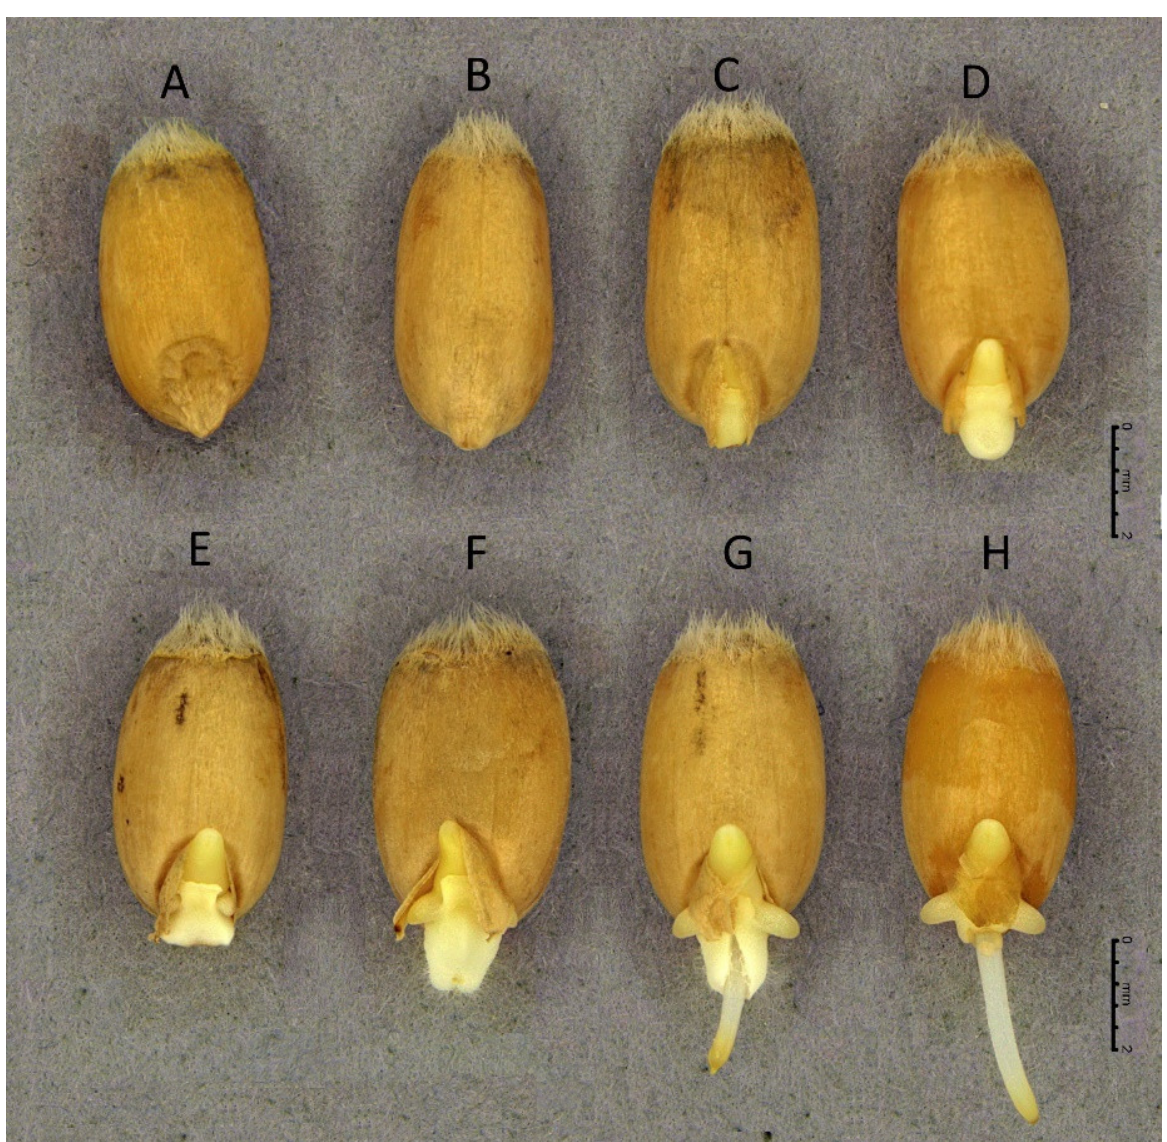
Figure 3. Morphological characteristics of big seeds of winter wheat ( Triticum aestivum ) during the first 24 h of germination, after seeding (AS) on moistened filter paper, illustrating the visible emergence events: ( A ) Dry seed at 0 h AS; ( B ) Imbibed seed with an expanded embryo at 4 h AS; ( C – E ) Seeds with emerged coleorhiza between 8–12 h AS; ( F ) Seed with emerged coleorhiza nearing completion of the germination process, between 12–16 h AS; ( G ) Completely germinated seed with emerged radicle visibly rupturing the coleorhiza, at 16 h AS; ( H ) Completely germinated seed with well-visible emerged radicle of at least 2 mm length, between 20–24 h AS.